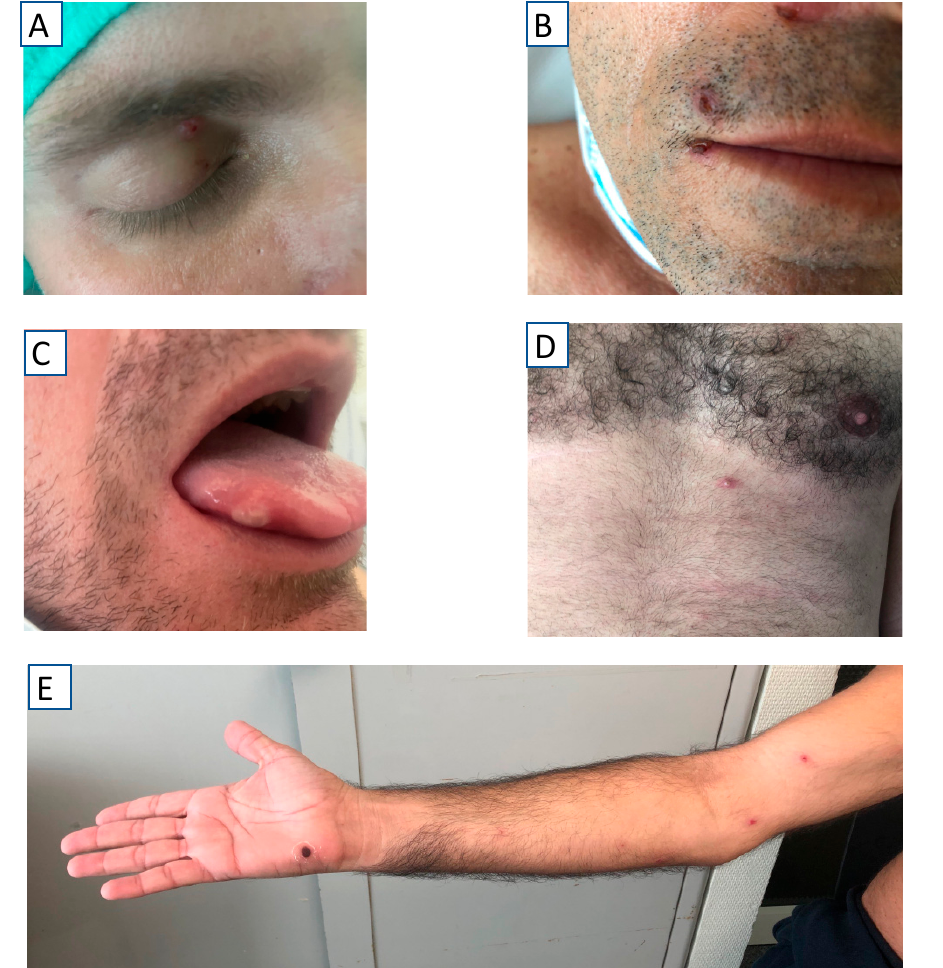
GF Figure 3. Cont